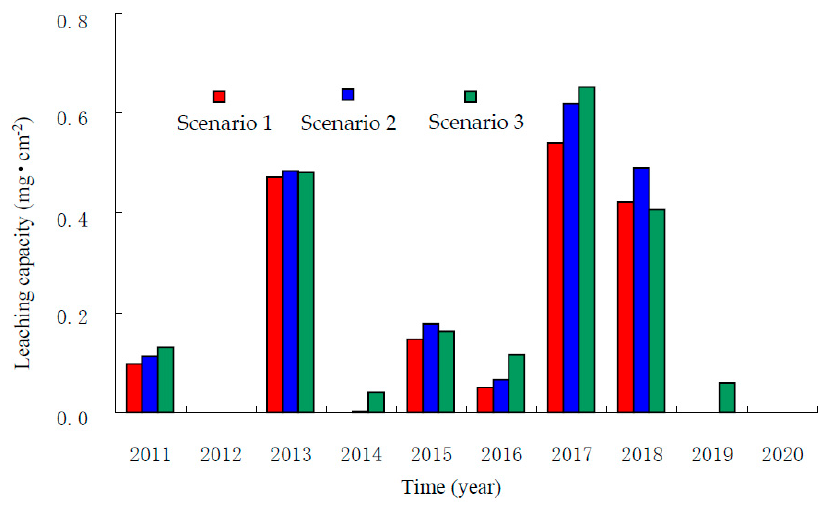
Figure 13. Leaching of the nitrate nitrogen reserves in the root zone (60 cm) of cotton.